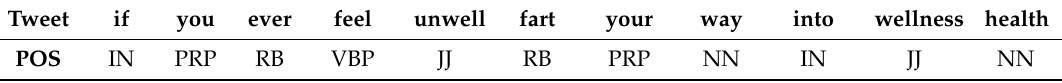
Table 5. Additional POS features. IN: preposition or subordinating conjunction; PRP: presonal